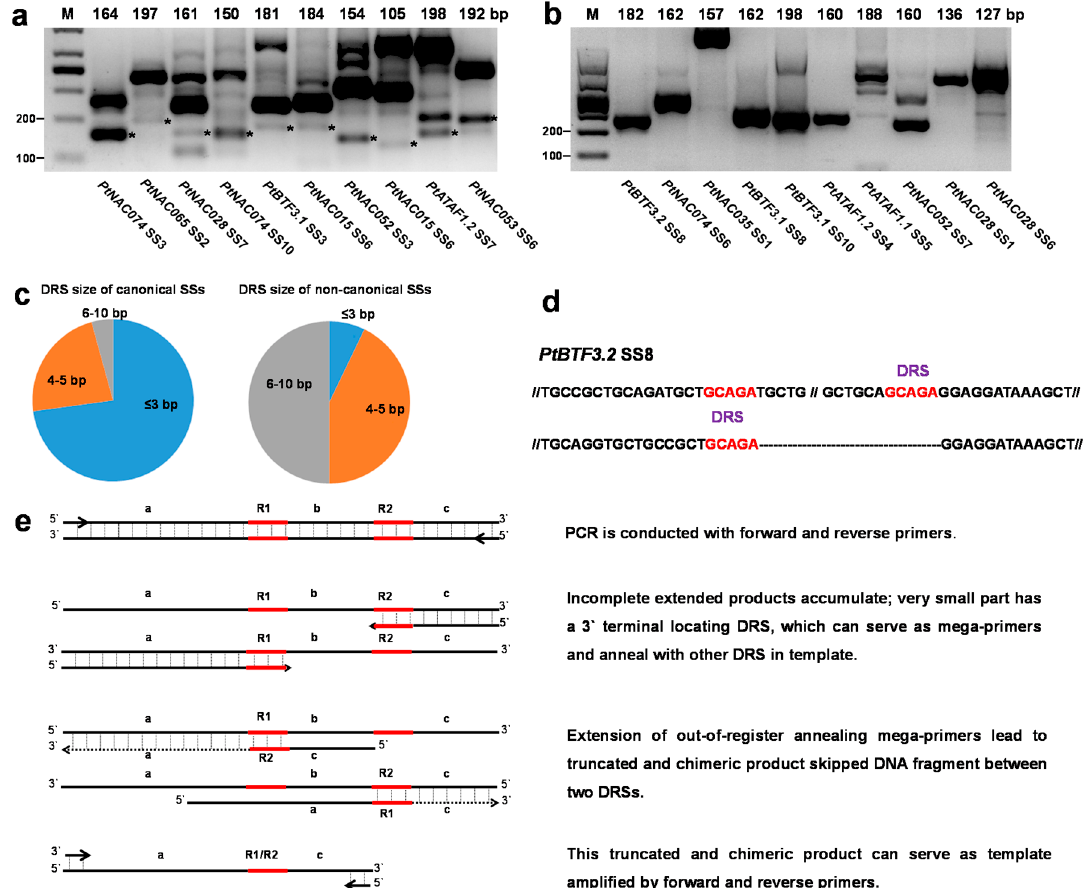
Figure 3. Canonical and non-canonical SSs verified by RT-PCR and the model explaining DRS-mega-primer-mediated amplification. ( a ) Ten canonical SSs verified by RT-PCR. Lanes 2–11 are PtNAC074 SS3, PtNAC065 SS2, PtNAC028 SS7, PtNAC074 SS10, PtBTF3.1 SS3, PtNAC015 SS6, PtNAC052 SS3, PtNAC015 SS6, PtATAF1.2 SS7 and PtNAC053 SS6; ( b ) Ten non-canonical SSs verified by RT-PCR. Lanes 2–11 are PtBTF3.2 SS8, PtNAC074 SS6, PtNAC035 SS1, PtBTF3.1 SS8, PtBTF3.1 SS10, PtATAF1.2 predicted size of the PCR product when splicing occurred at the detected SS. Asterisks indicate bands which were consistent with prediction; ( c ) Distribution of DRSs flanking canonical and non-canonical SSs; ( d ) Alignment of PtBTF3.2 and its sequencing reads covered SS8. DRSs flanking SS8 are marked in red; ( e ) Model explaining the generation of DRS-mega-primers and how artifacts were amplified by